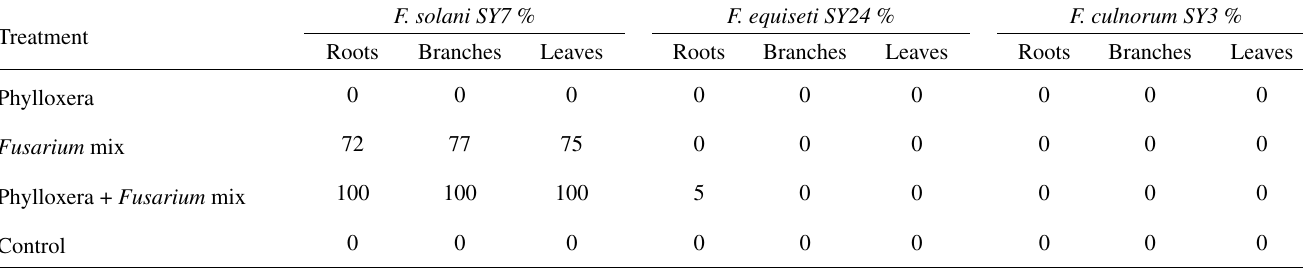
Data represents the infection percentage of Fusarium spp. ratio in roots, branches and leaves in each